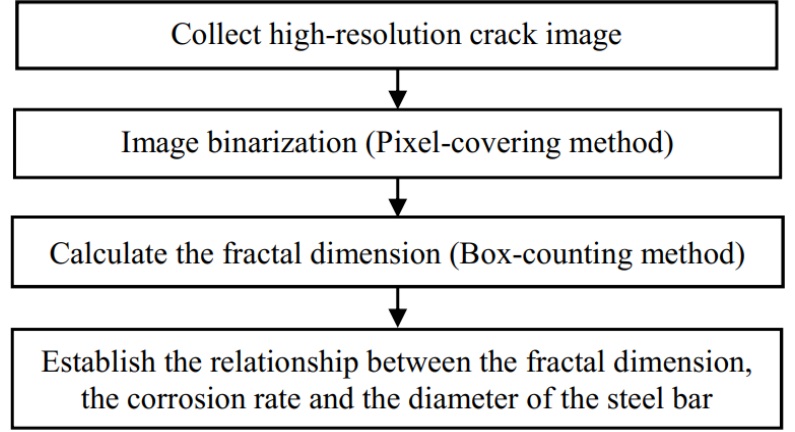
Figure 4. Flowchart of the proposed algorithm.